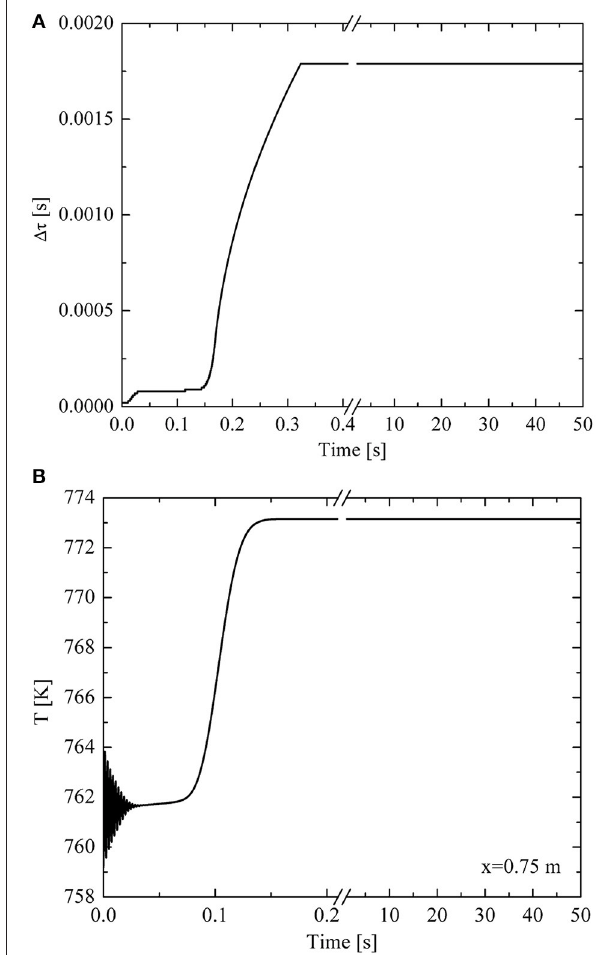
FIGURE 16 | Relationship between time step (A) , temperature (B), and time considering CFL condition. (A) Time step. (B)